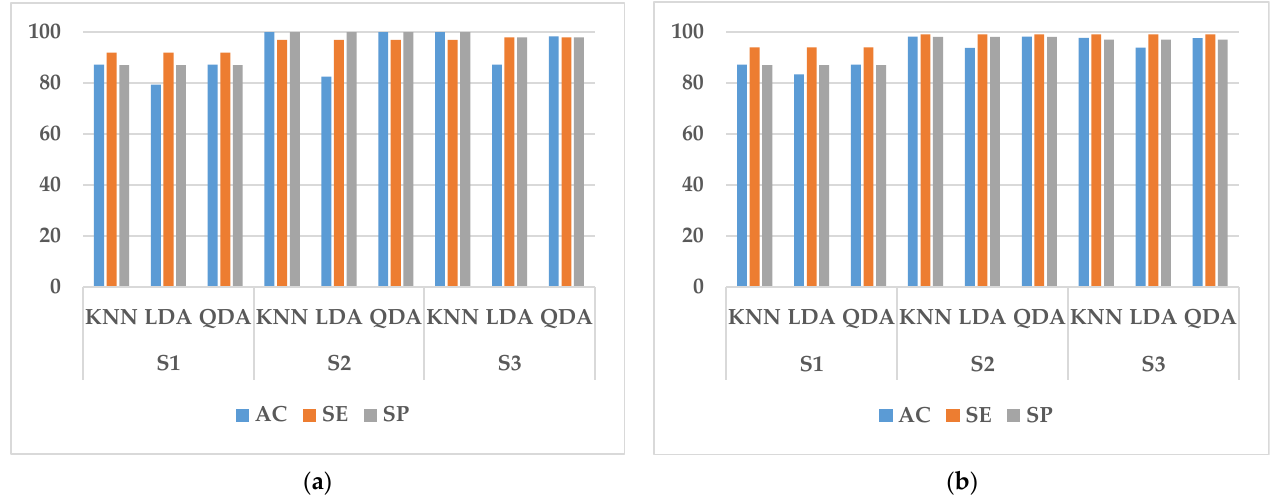
Figure 5. Random cross-validation of ECG data. ( a ) Vehicle driving experiment; ( b ) Simulated driving experiment.